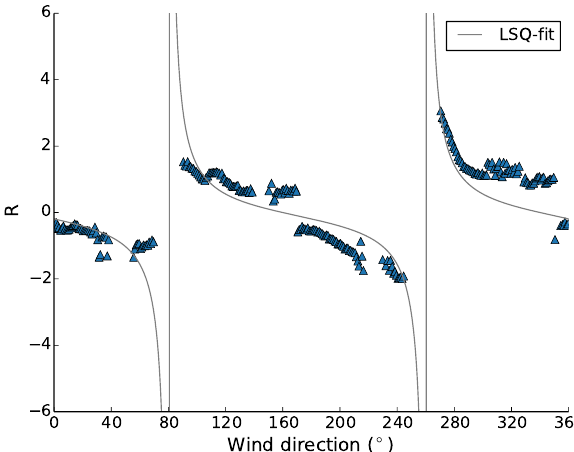
Figure 14. Calibration function R during sols